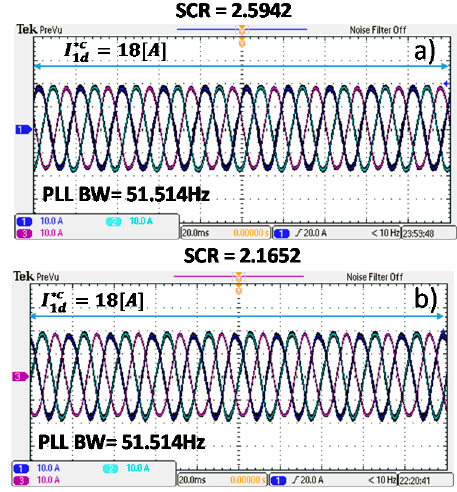
Figure 10. Experimental results: ( a ) Maximum active current injected by the converter into the grid for SCR = 2.5942 and PLL bandwidth of 51.514 Hz (10 A/div); ( b ) Same as a) but with SCR = 2.1652 (10 A/div).